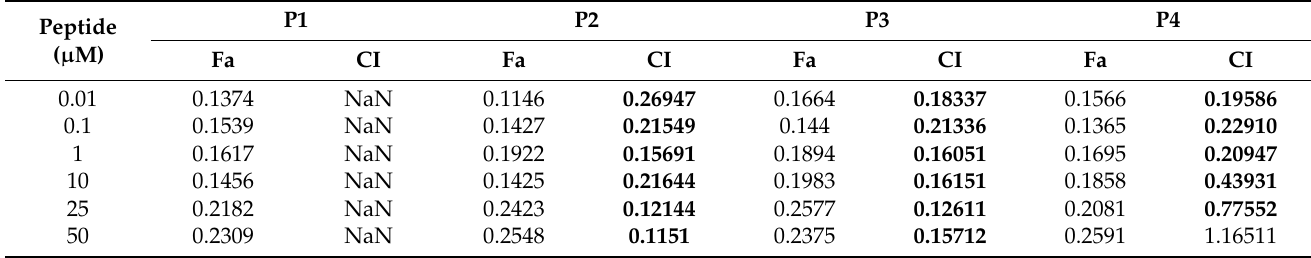
Table 4. Fractional effect (Fa) and CI values of peptides and 5-FU (3 µ M) combinations for 48 h in HT-29 cells. C1 < 1 represents synergism, CI = 1 represents additivity, and C1 > 1 represents antagonism. The fractional effect shows the degree of cell death, with zero being no cellular death and one being total cellular death. CI in bold indicates drug pairs that are